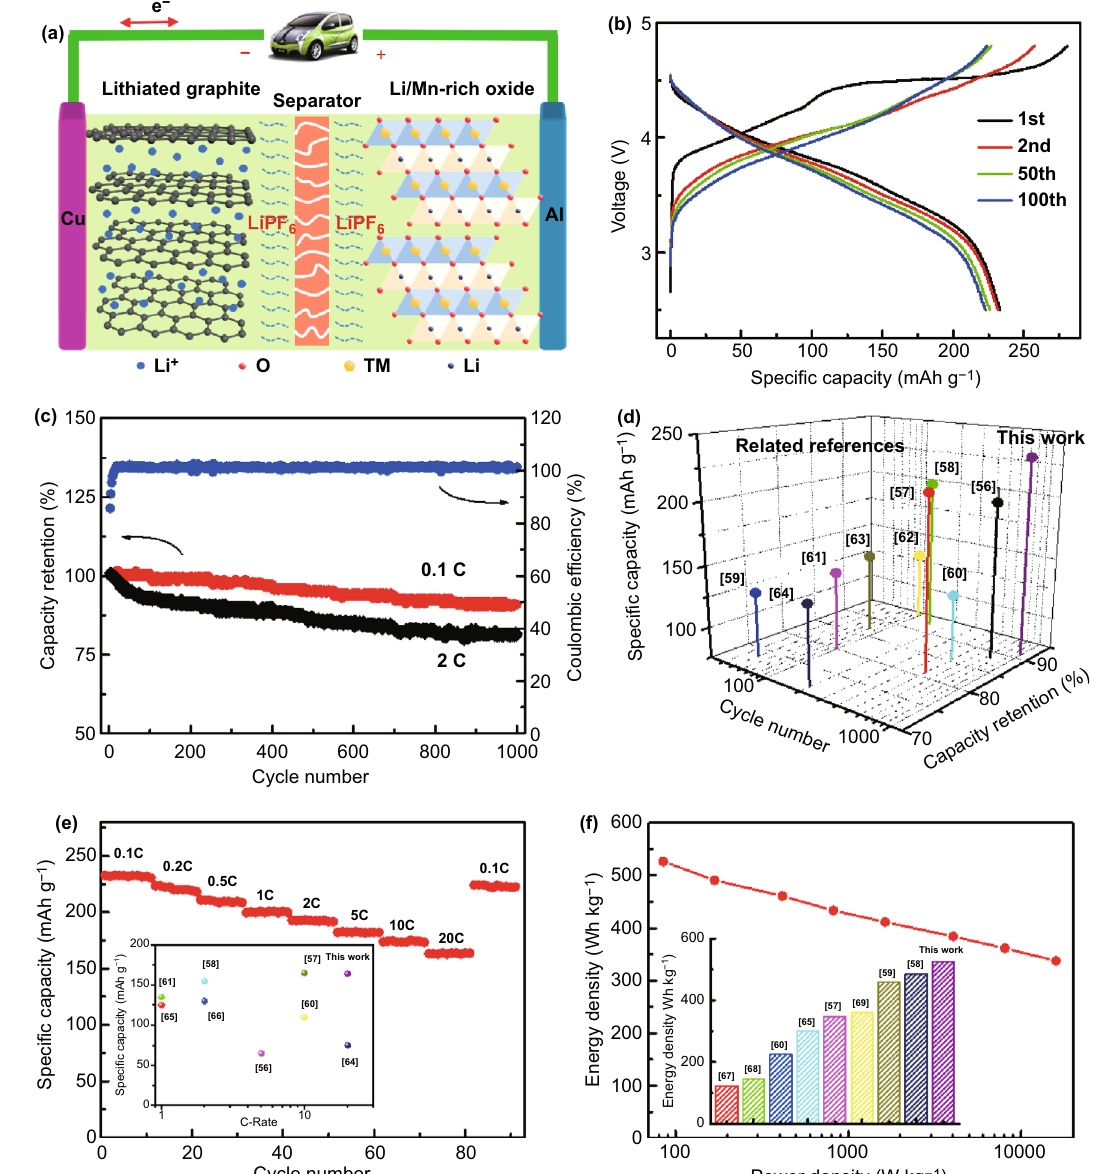
Fig. 6 Electrochemical performance of GCNT@ST-MNC//nanographite full cell. a Schematic of the assembled full cell. b Galvanostatic charge/discharge curves with 1st, 2nd, 50th and 100th cycle at 0.1 C. c Cycling performance at 0.1 C and 2 C (Coulombic efficiency at 0.1 C). d Comparison of specific capacity and cycling performance of our work with other reported full cells. e Rate performance at various rates from 0.1 to 20 C (the inset is the comparison of specific capacity at high rate). f Ragone plots based on total mass of cathode and anode (the inset is the comparison of energy